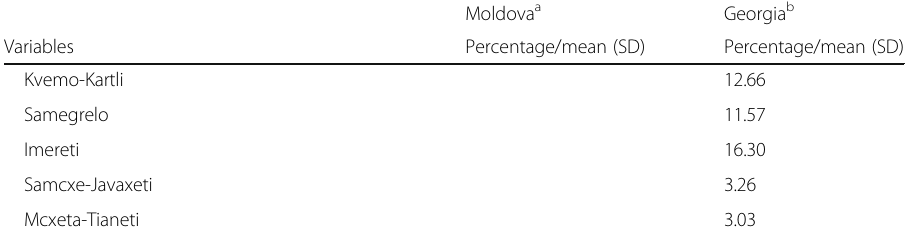
Table 1 Means/percentages (Standard Deviations) of dependent and independent variables